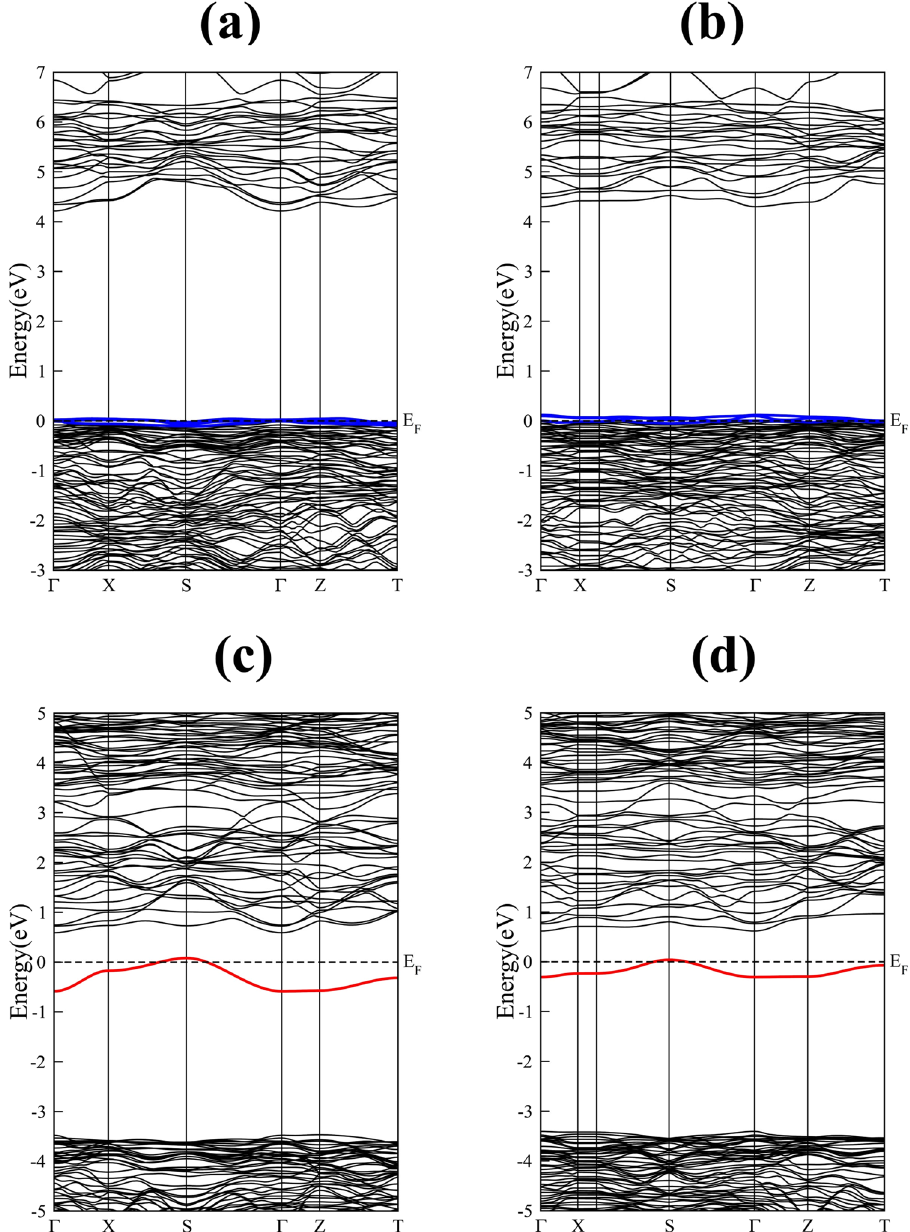
Figure 5. The calculated electronic band structures of charge-neutral ( a ) Ca, ( b ) Zr, ( c ) O 1 and ( d ) O 2 vacancy containing 2 × 1 × 2 supercells of CaZrO 3 . The Fermi level, occupied defect levels and unoccupied defect levels are indicated by dashed black line, solid red line and solid blue lines,